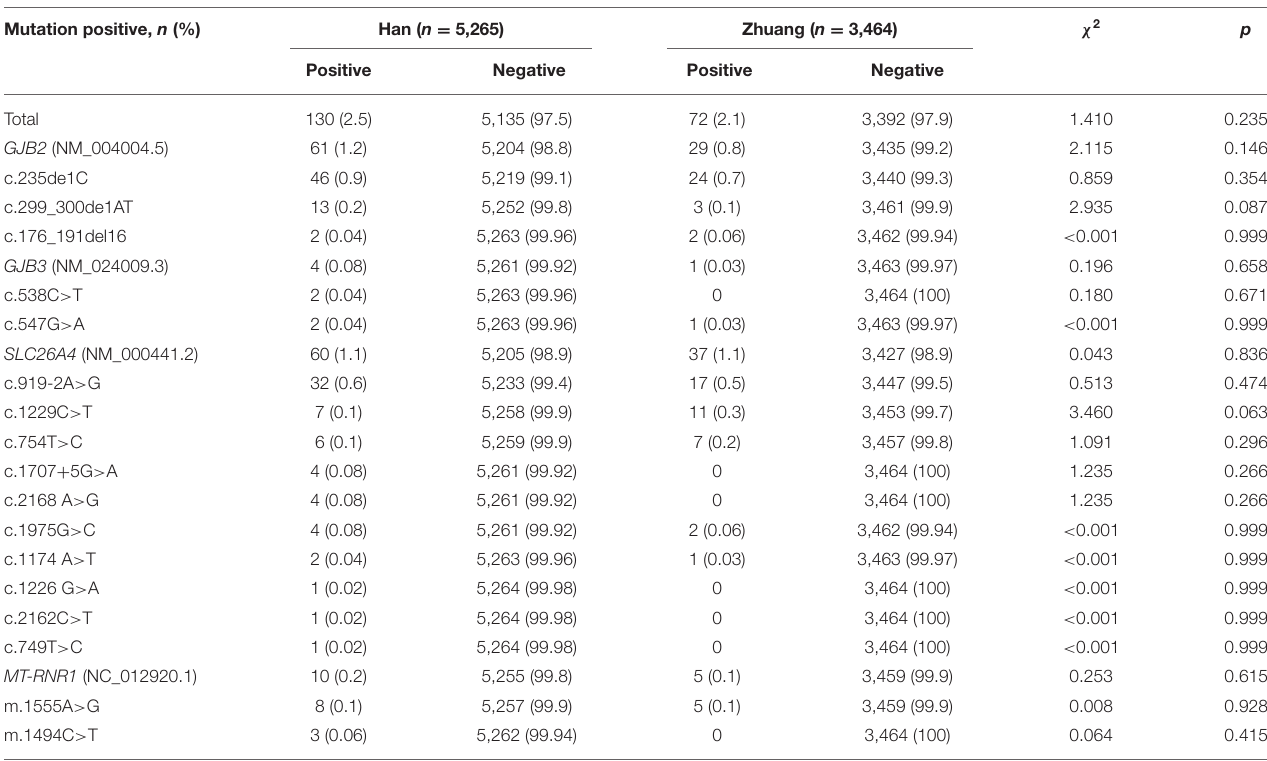
TABLE 5 | Comparison of hearing loss-associated mutations between Han and Zhuang groups. Mutation positive, n (%) Han ( n = 5,265) Zhuang ( n =